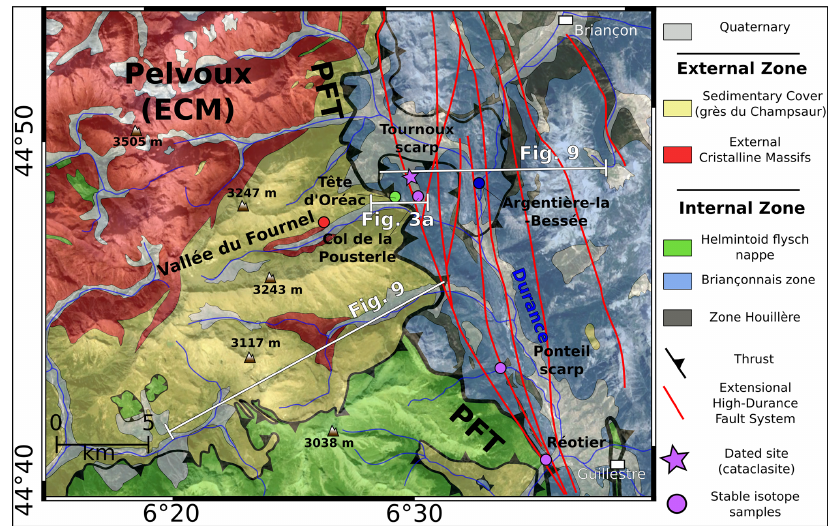
Figure 2. Study area of the Penninic frontal thrust, east of the Pelvoux external crystalline massif (ECM). The High Durance fault system is represented in red from Tricart et al. (2001) and Sue et al. (2007). Location of sampled sites is indicated. The location of the extensional fault dated by U–Pb on calcite (samples FP18-2 and FP18-3) is marked by a star. Colour of site circle refers to the host rock age: red, Eocene sandstone flysch (grès du Champsaur); green, Cretaceous carbonates; blue, Jurassic carbonates; purple, Triassic carbonates. Sample descriptions are shown in Fig. S1. © Google Earth for background relief